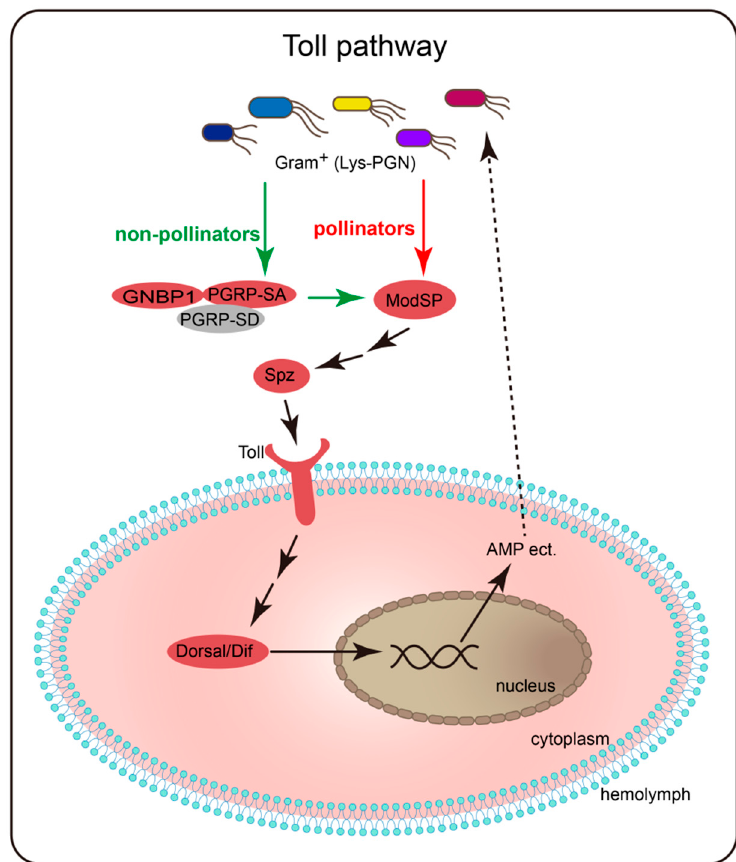
Figure 5. A schematic diagram of initiation of the Toll pathway among pollinators and non-pollinators. The putative recognition pathway of pollinators is indicated by red arrow, while that of non-pollinators is indicated by green arrows.